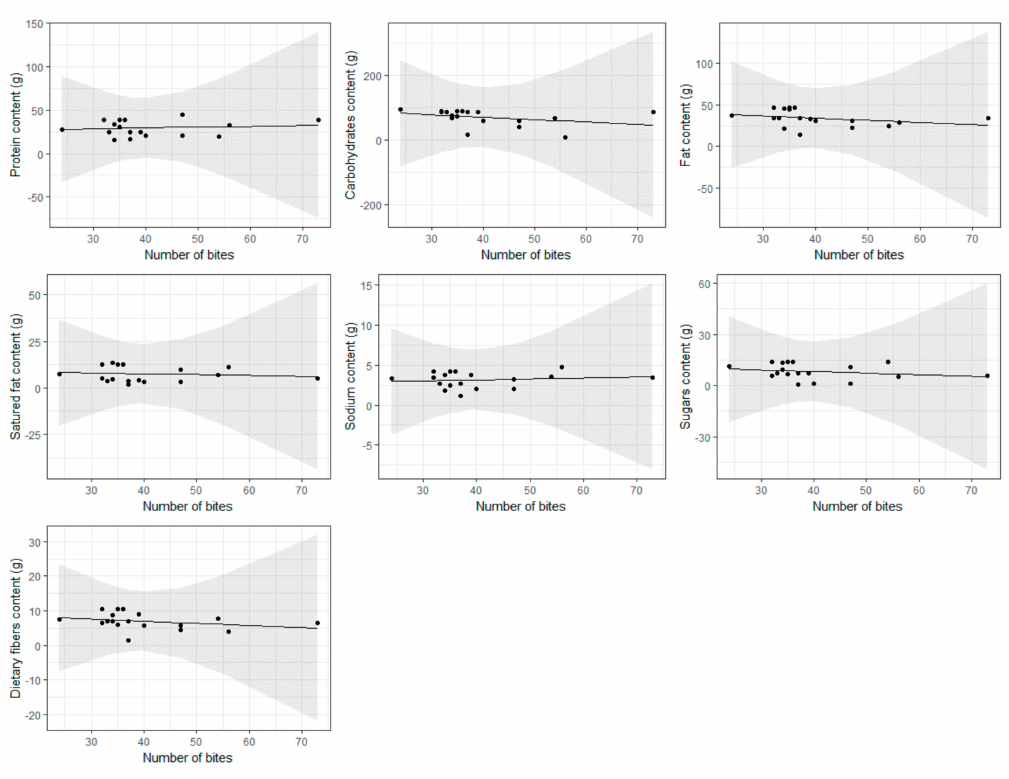
Figure 3. Association between the number of bites, reported on the x -axis, and nutritional values in (g), reported on the y -axis. Lines and bands represent the estimated error and relative 95% C.I.,